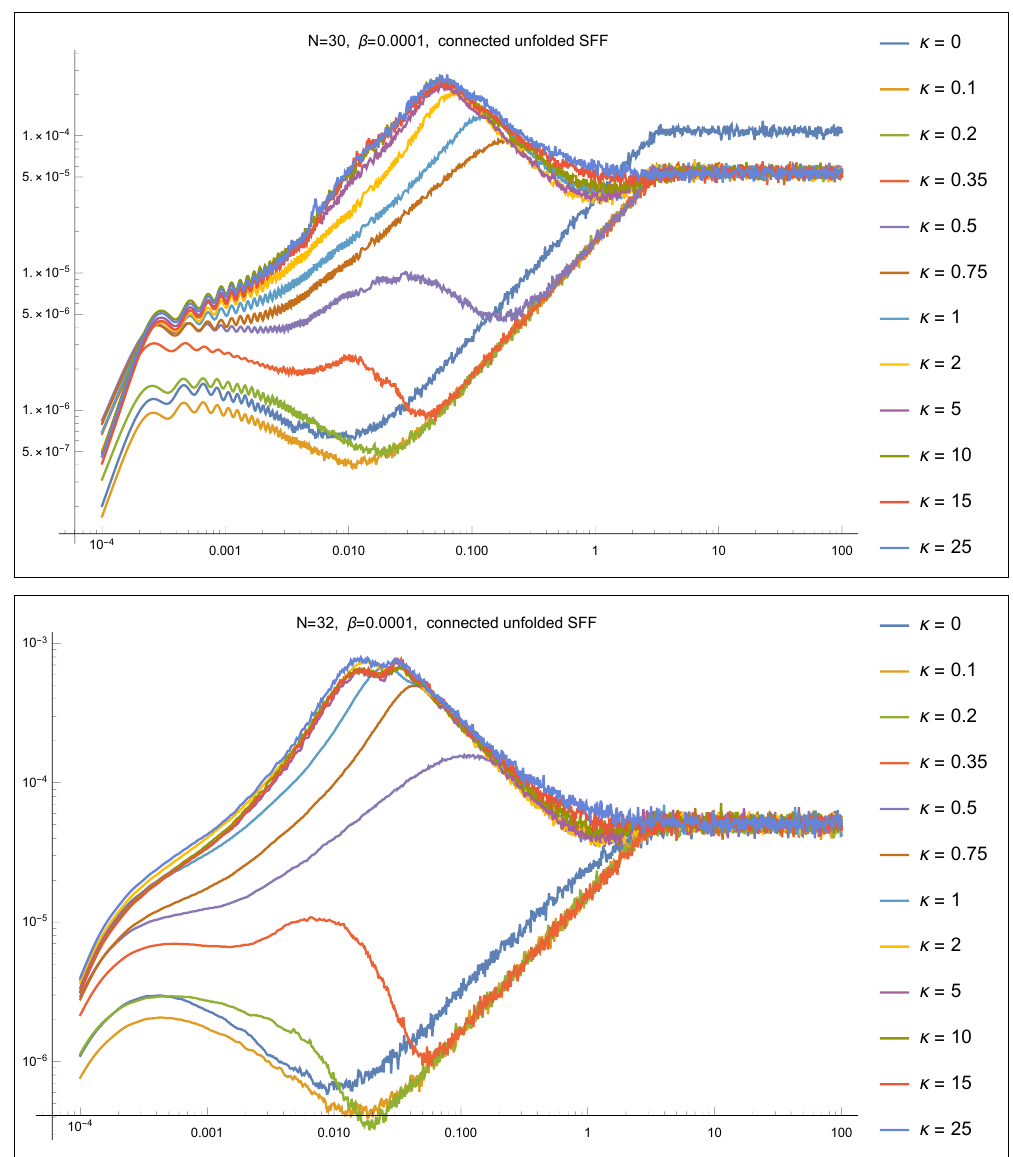
Figure 4 . The connected unfolded SFF for N = 30 ; 32 and (cid:12) = 0 :